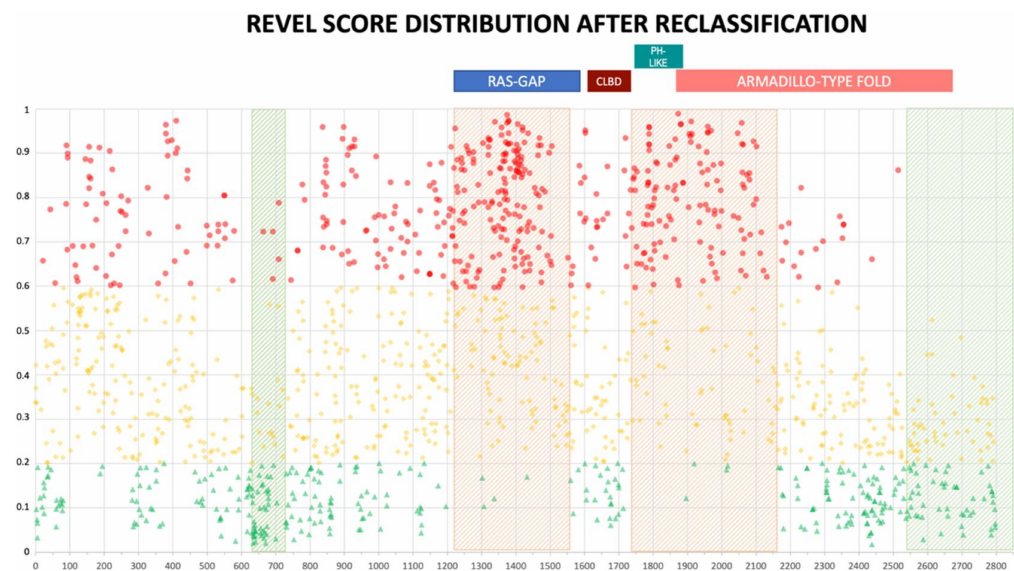
Figure 5. REVEL prediction score values distribution throughout the NF1 protein. Above, the location of the four NF1 InterPRO domains (RAS-GTPase aa 1210–1549; CRAL-TRIO LIPID BINDING DOMAIN aa 1581–1726; PH-LIKE Pleckstrin homology domain aa 1727–1837; Armadillo type fold aa 1849–2676). Green triangles are LEANING BENIGN scores, yellow diamonds VUS scores, red circles LEANING PATHOGENIC scores. Shaded in red are regions with clustering of LEANING PATHOGENIC variants with high prediction scores (aa 1200–1440, and 1725–1250), while green shading indicates regions where no or few LEANING PATHOGENIC variants are present (aa 2530–2849 and 600–700,